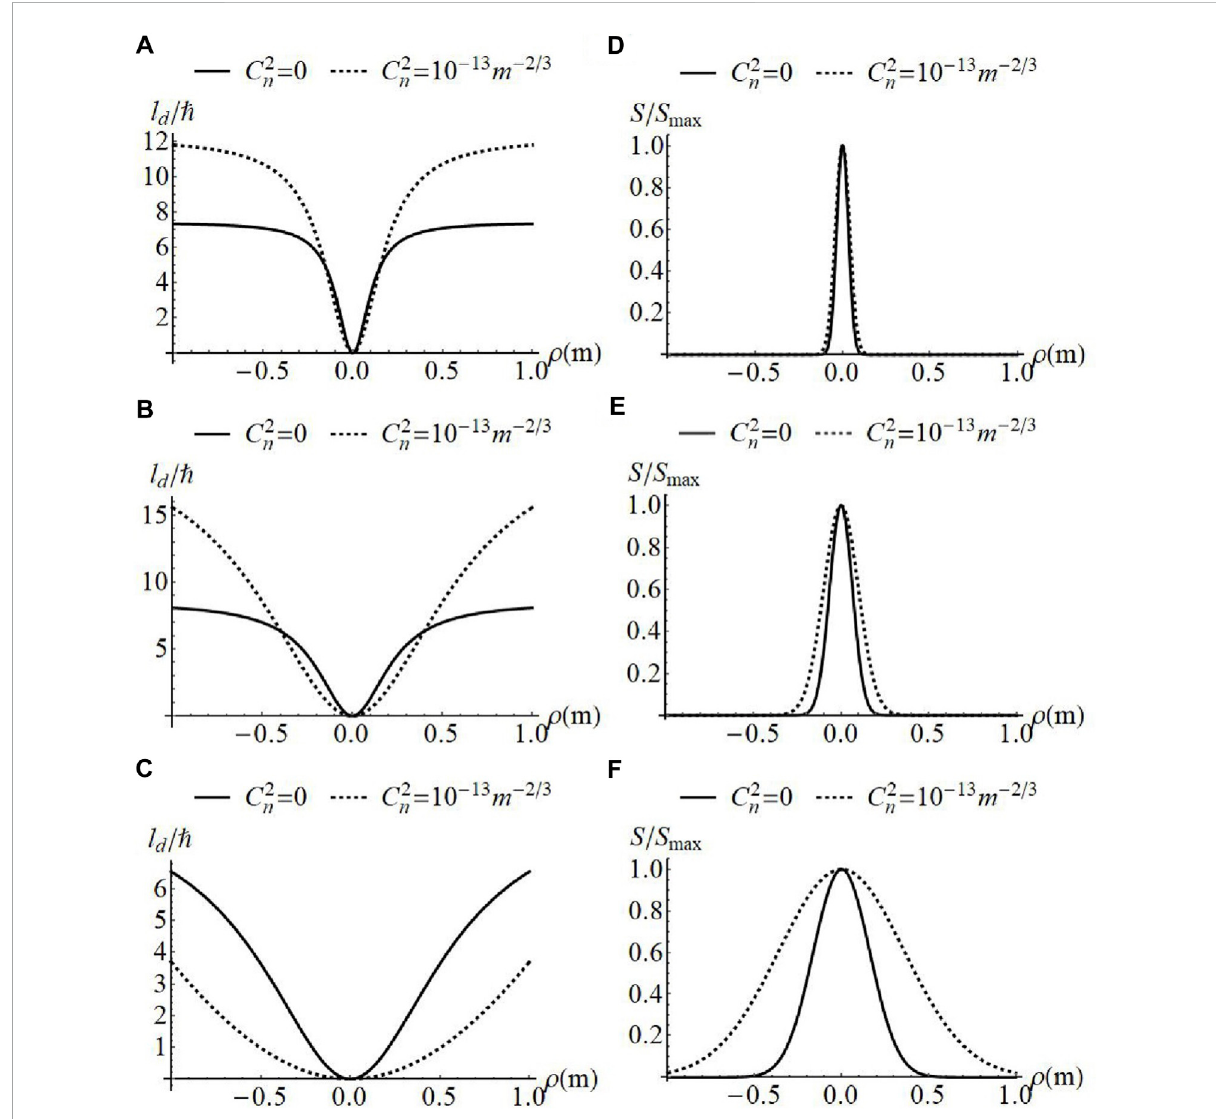
FIGURE 1 NormalizedOAM fl uxdensity (A – C) andspectraldensity (D – F) ofGSMVbeamswith w =10 mm, δ (cid:2) 5mm,at z =1 km (A,D) , z =2 km (B,E) ,and z = 5 km (C,F)